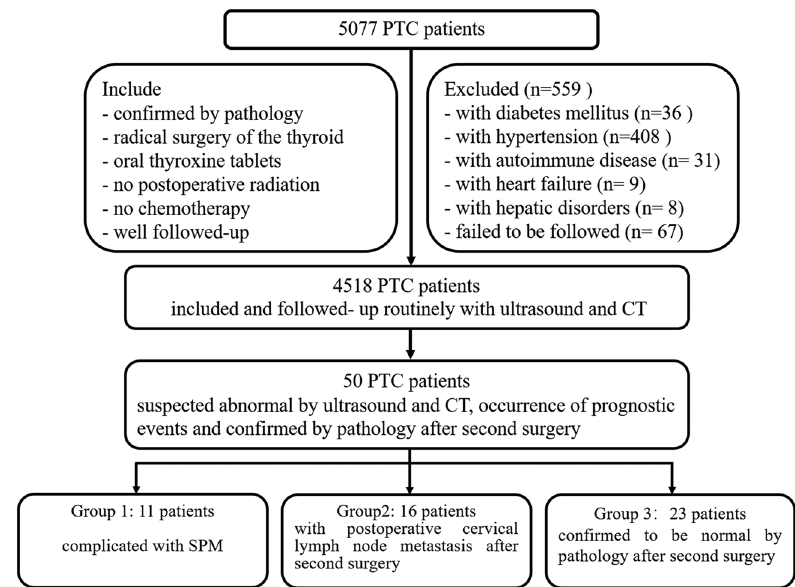
Figure 1: Flow diagram of standards for patient inclusion and exclusion